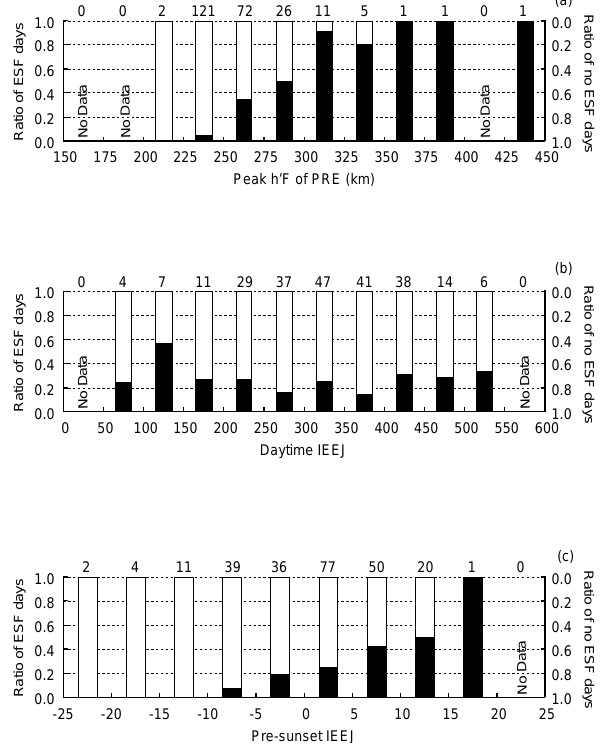
Fig. 3. Dependence of the ESF occurrences on the peak h 0 F of PRE (a) , daytime (b) and pre-sunset IEEJ (c) . Solid and open bars indicate the ratios of ESF and no ESF days to the total number of days contained in each bin. The total number of days in each bin is given on the top of each bar.